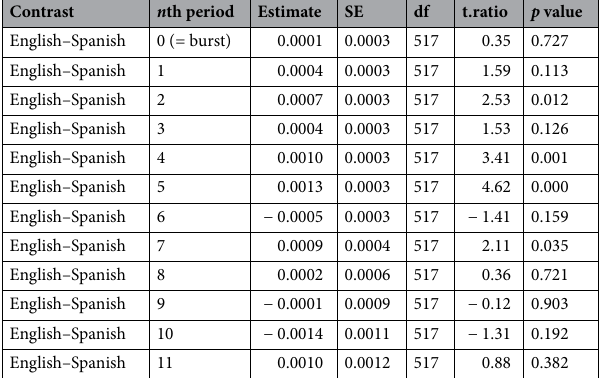
Table 2. Pairwise contrasts in peak timing difference between English and Spanish (despite significant interactions pooled across replications) in the Generator network (with emmeans package 70 ). The burst is marked by the 0th period. The 12th period is not estimated due to lack of